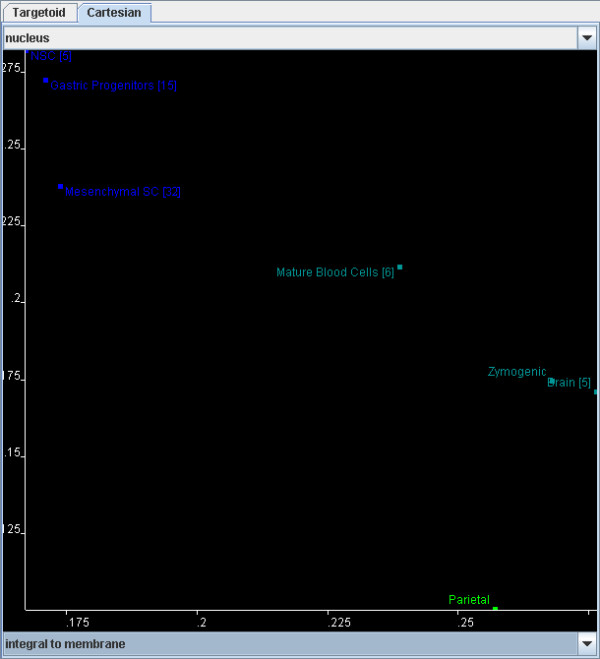
The GOurmet Cartography Cartesian plotting window. This window toggles with the Targetoid plot. Here, users can select one GO term as the y-axis and one as the x-axis. All the expression profiles are plotted according to their fractional representation of the selected GO terms. Note how the two selected GO terms ("nucleus" and "integral to membrane") distinguish expression profiles of stem/progenitor cells as a group from those of differentiated cells.